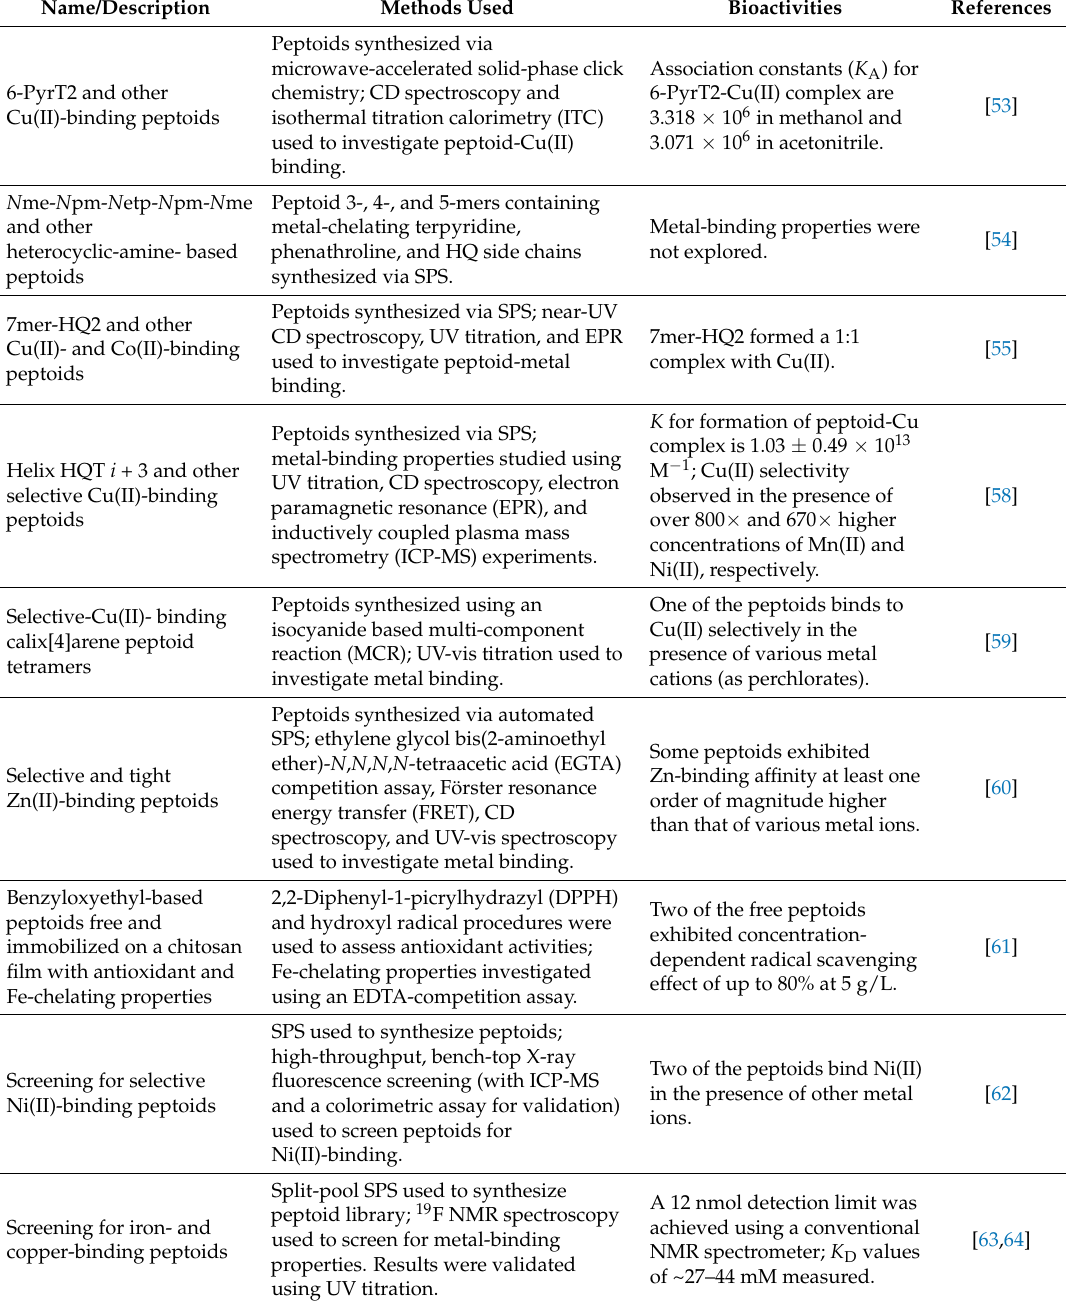
Table 3. Methods used and bioactivities reported for example metal-chelating